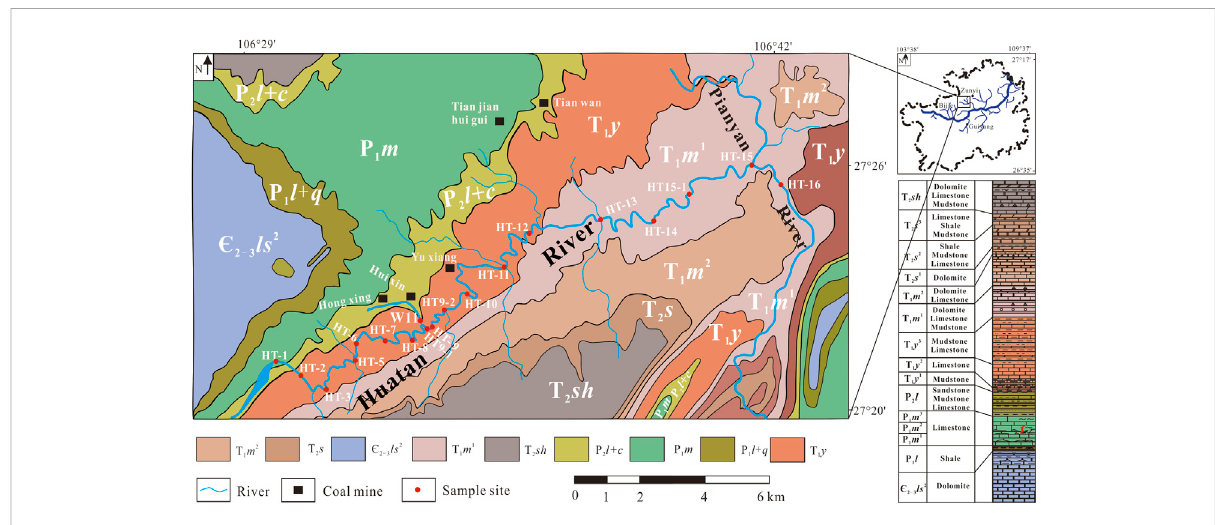
FIGURE 1 Distribution of stratigraphic outcrops and sampling points in the Huatan River watershed (after Huang et al.